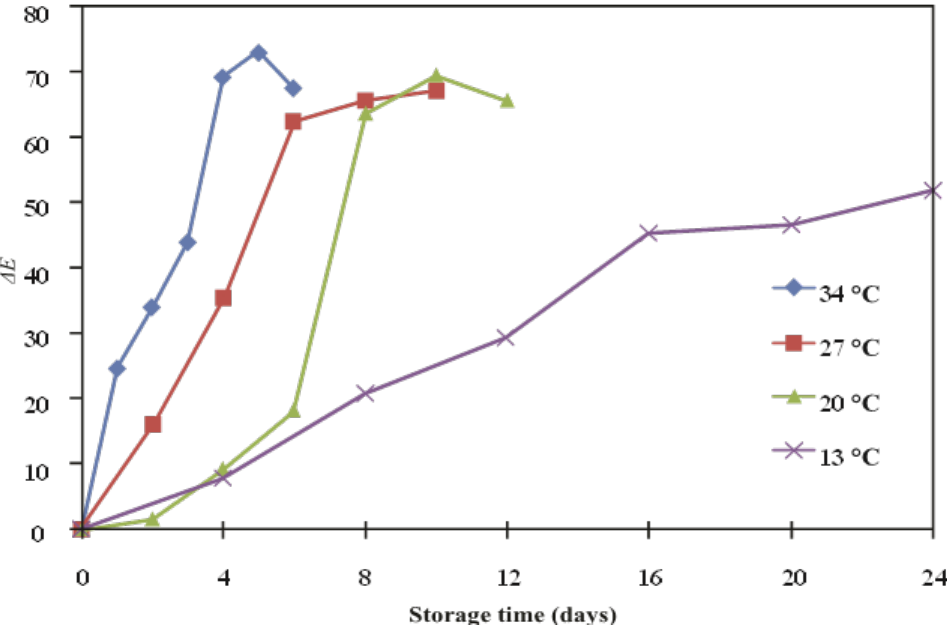
Figure 3. Effect of storage time and temperatures on ∆ E values of indicator labels in the packaged mangoes.